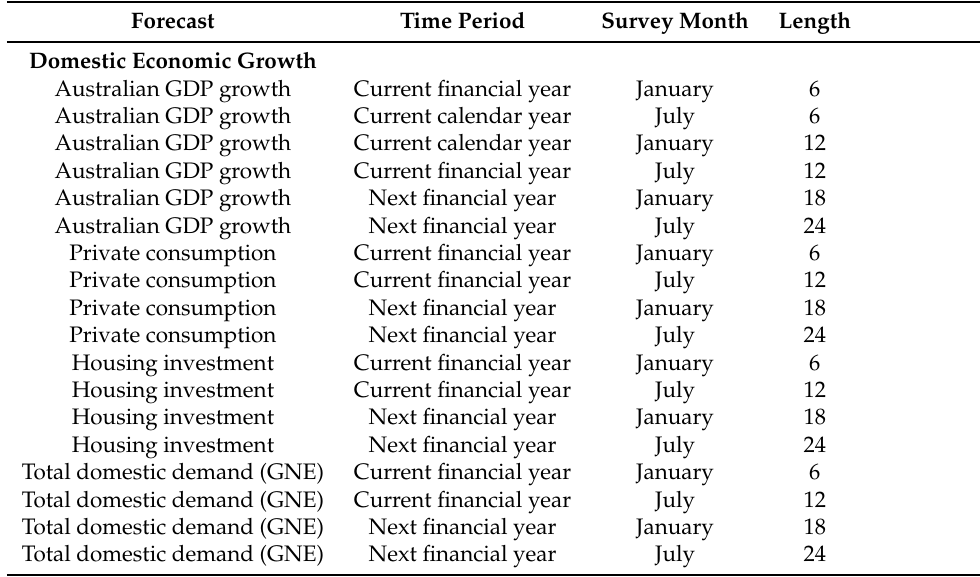
Table A1. Survey questions. The last column represents the forecast length measured in